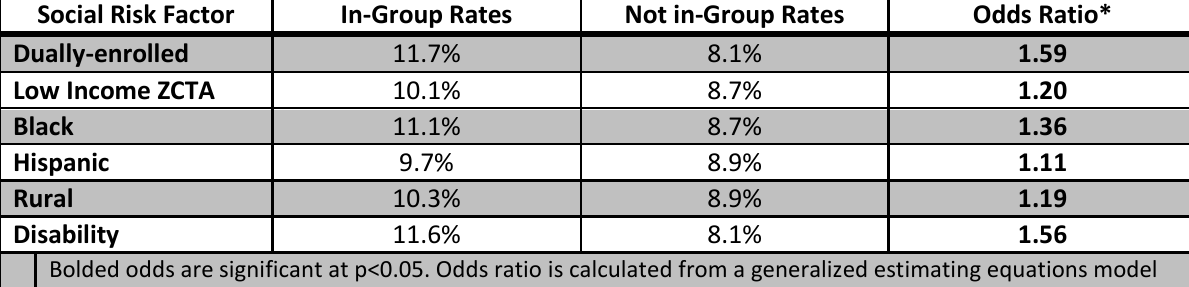
Table 13.5: Patient Level Social Risk Factors and ED Use Rates, FYs 2012-2014 Social Risk